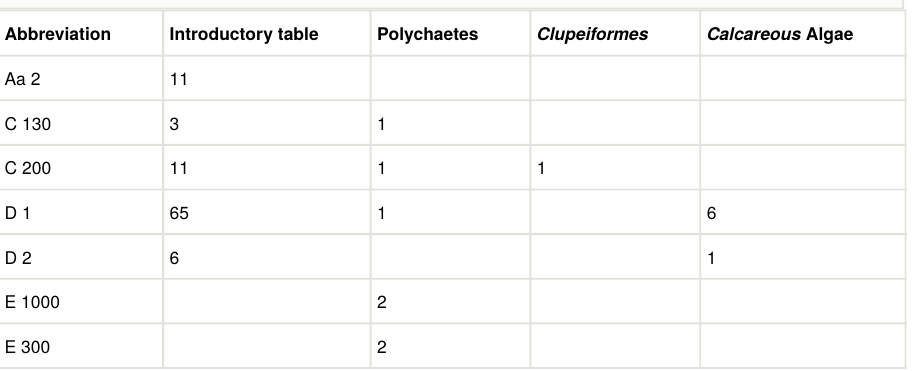
Numbers of samples taken with each sampling gear during the "Thor" (and